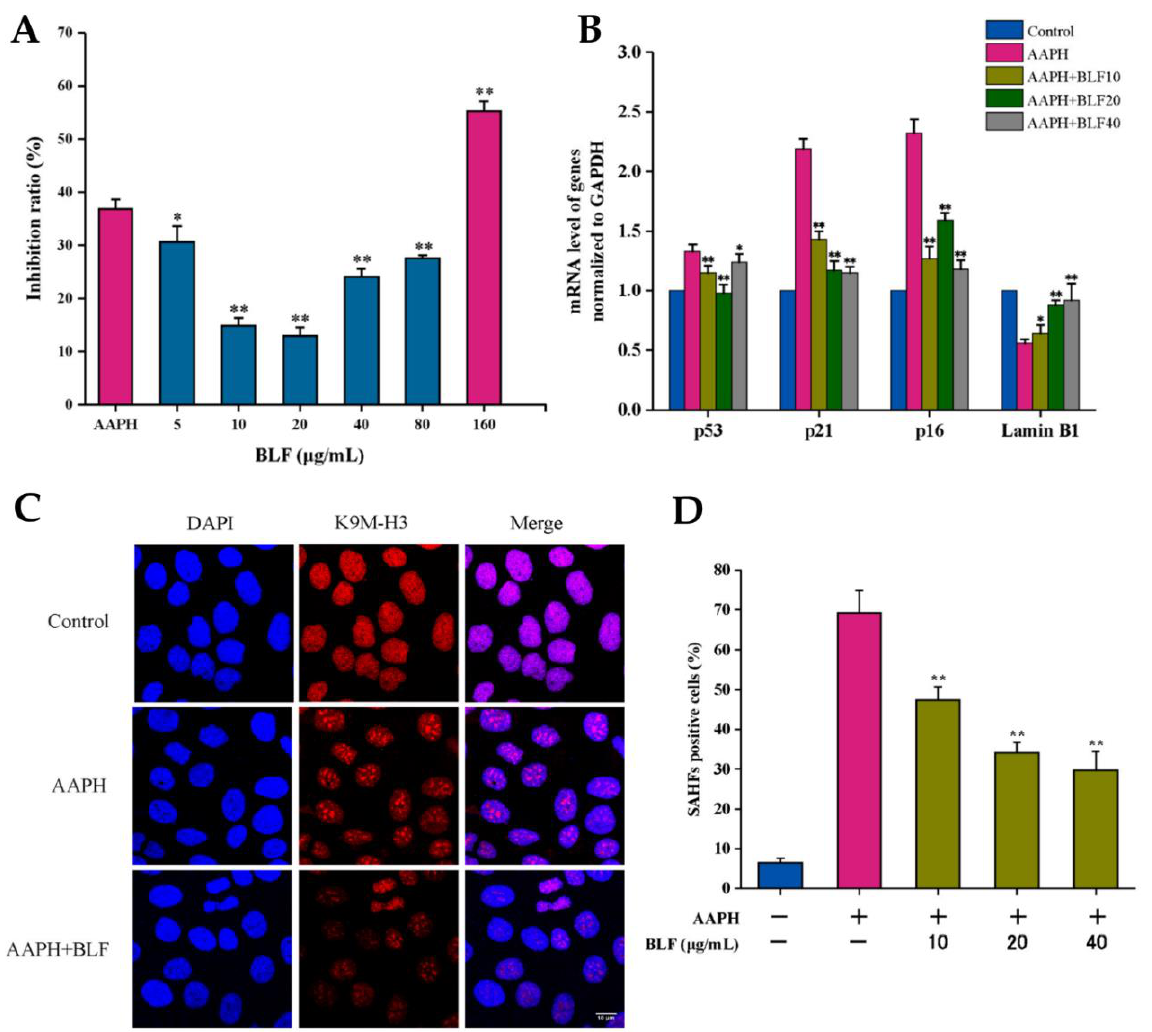
Figure 3. ( A ) Effects on HaCaT cell proliferation of different doses of bamboo leaf flavonoids, determined by MTT assay; ( B ) p53, p21, p16, and Lamin B1 gene expression after treatment with bamboo leaf flavonoids, by quantitative real-time PCR; ( C ) confocal microscope photographs showing senescence-associated heterochromatin foci formation after treatment with bamboo leaf flavonoids; ( D ) percentage of senescence-associated heterochromatin foci-positive cells; * p < 0.05, ** p < 0.01; adapted from Gu et al. [30].